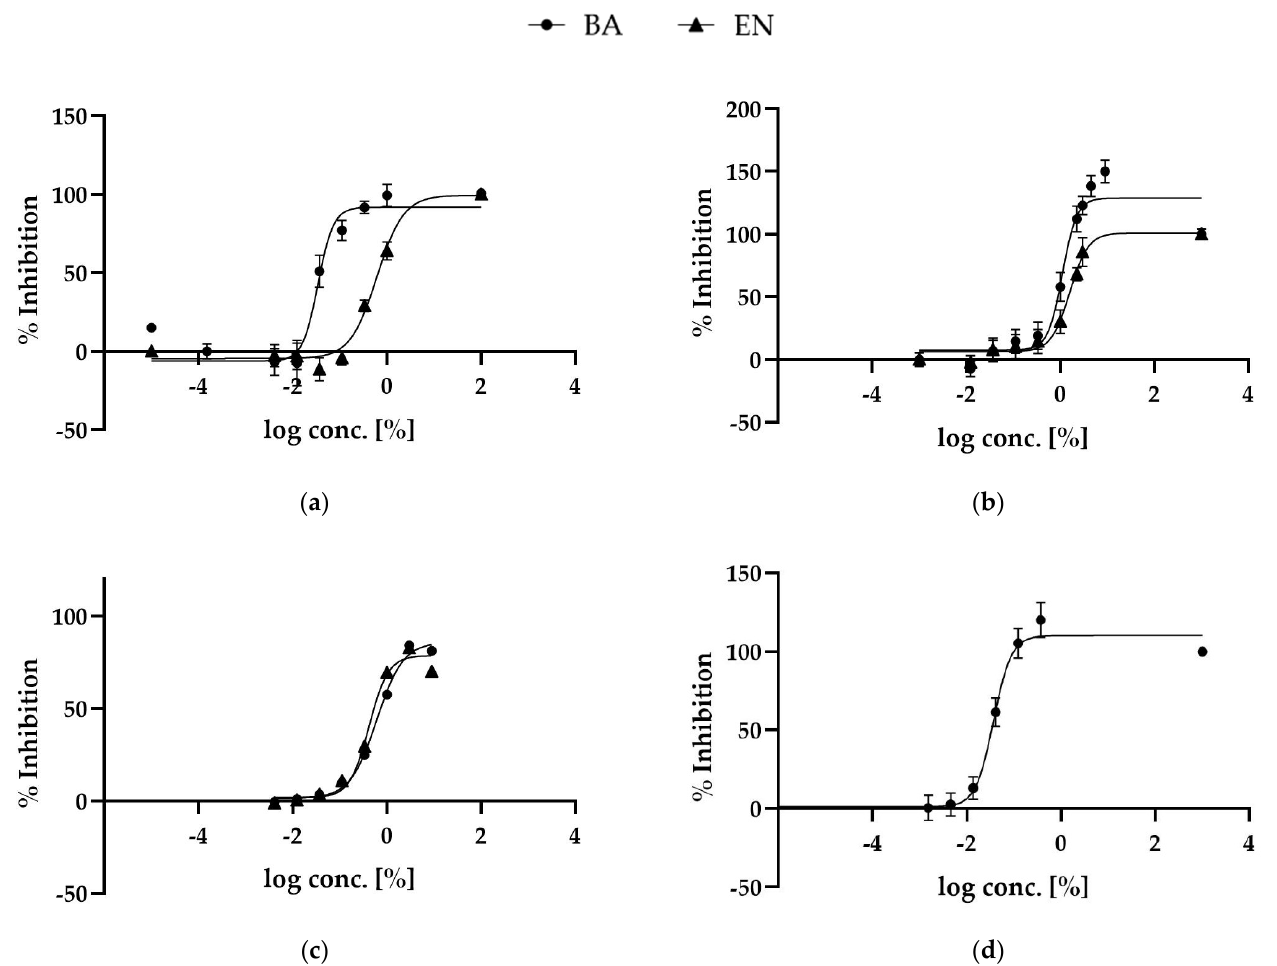
Figure 4. Summary of IC50 of the two extracts BA (circle) and EN (triangle) in ( a ) KLK5 ( n = 3), ( b ) hyaluronidase ( n = 3), ( c ) DPPH ( n = 3) and ( d ) COX2 ( n = 4) inhibition assays. Plotted values are displayed as mean (±SD).